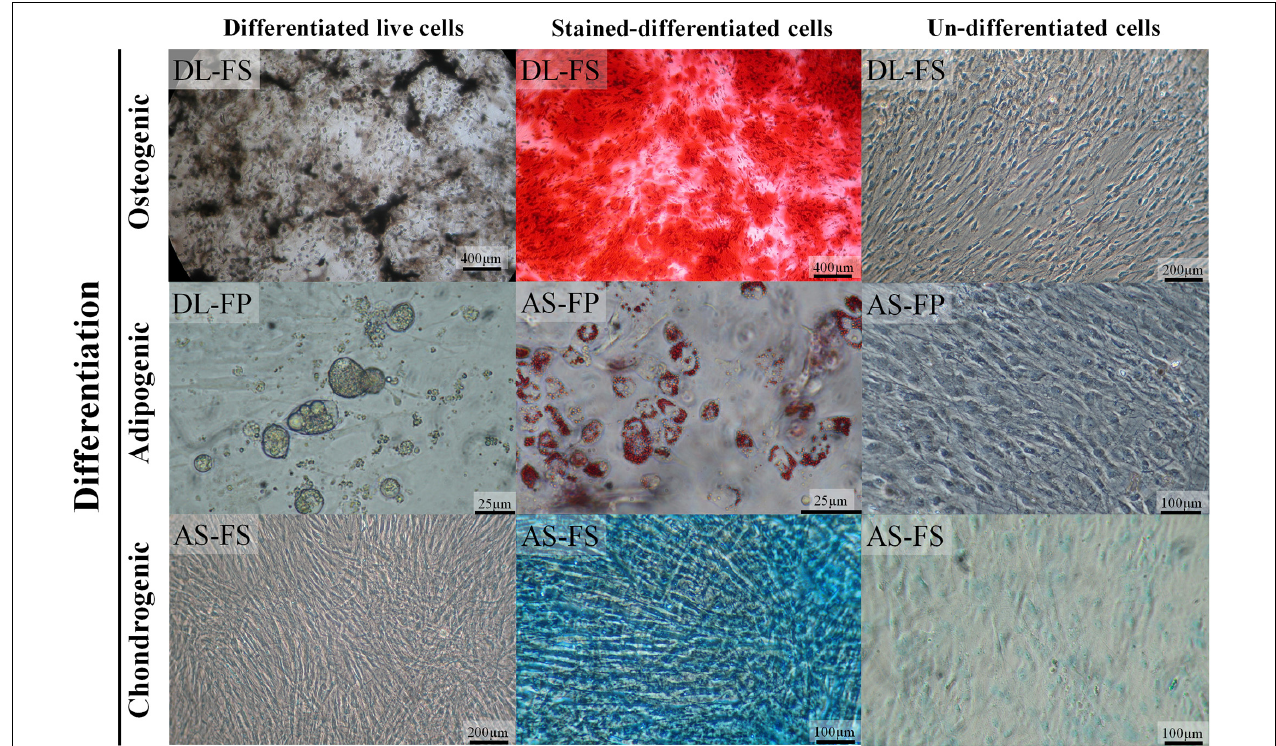
FIGURE 3 | SMSCs derived from different synovial tissue sources in DL and AS breeds successfully differentiated into adipocytes, osteocytes, and chondrocytes under optimal conditions. In the late stages of osteogenesis after culturing in an osteogenic medium for 28 days, calcium deposits were revealed as brown–black lines or spots under a 4 × objective phase-contrast microscope and as red-brown after being stained with alizarin red. The lipid-vacuole and lipid-droplet formation of adipocytes was observable at 4 days of adipogenic differentiation; the cells were fixed and stained with Oil Red O to identify the lipid vacuoles (red). For chondrogenic differentiation, the cells were cultivated in a chondrogenic medium for 35 days; sulfated proteoglycans, including hyaluronic acid, were then stained with alcian blue 8GX (bluish-green/blue). The control cultured un-differentiated cells had a fibroblastic morphology under phase contrast similar to that observed before differentiation to chondrocytes, adipocytes, and osteocytes.